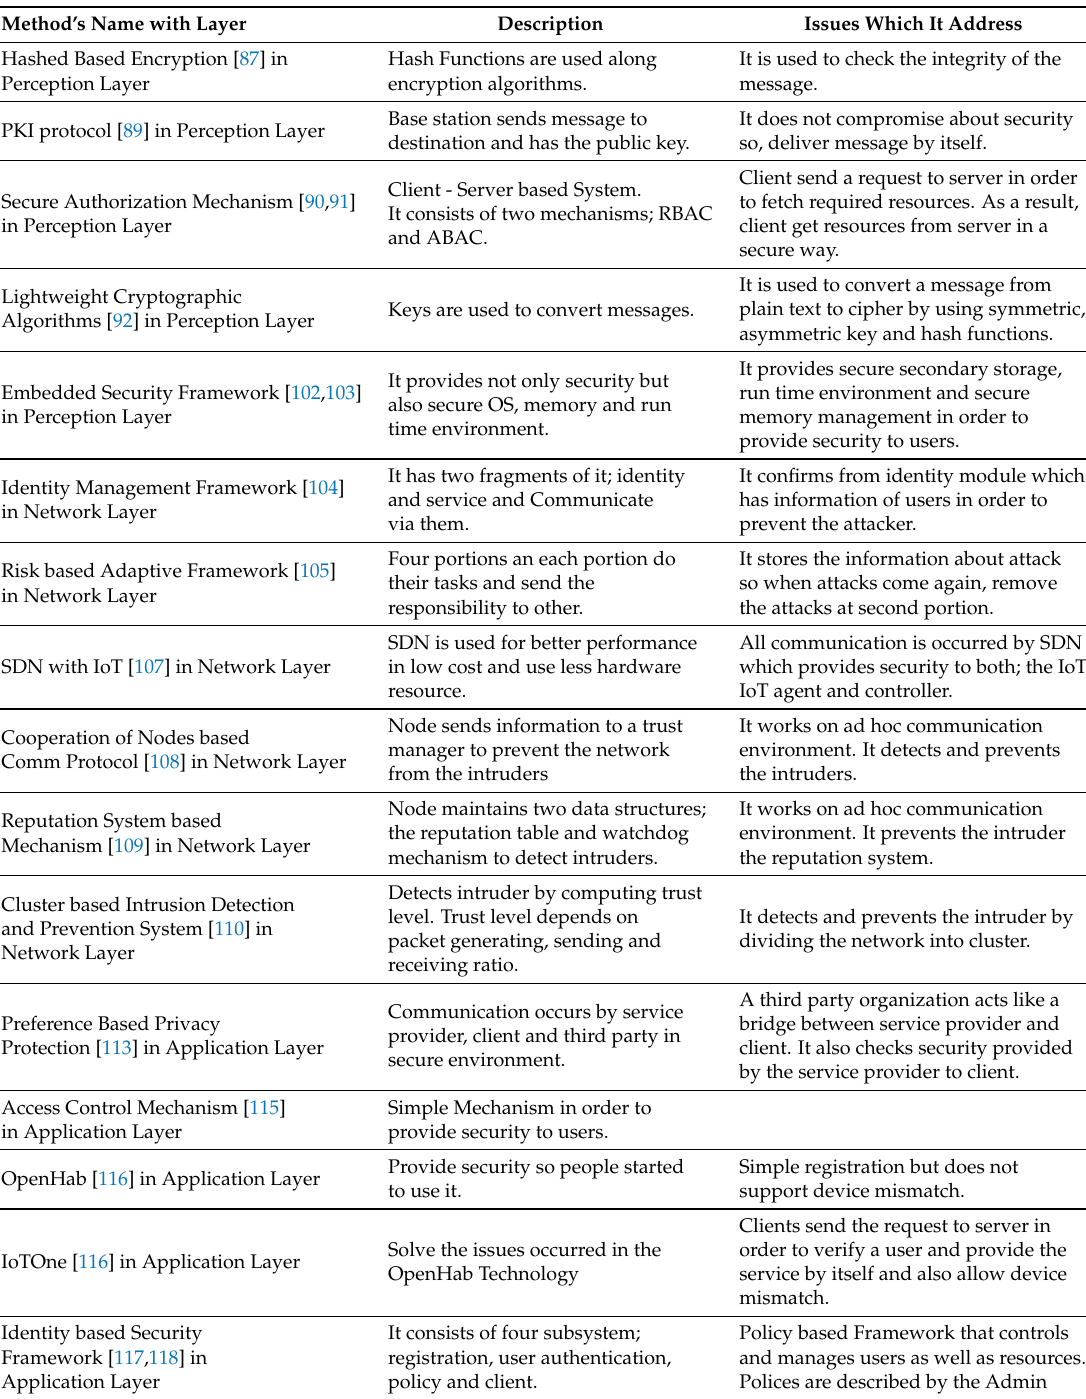
Table 4. Comparison of existing mechanisms along description with respect to security for